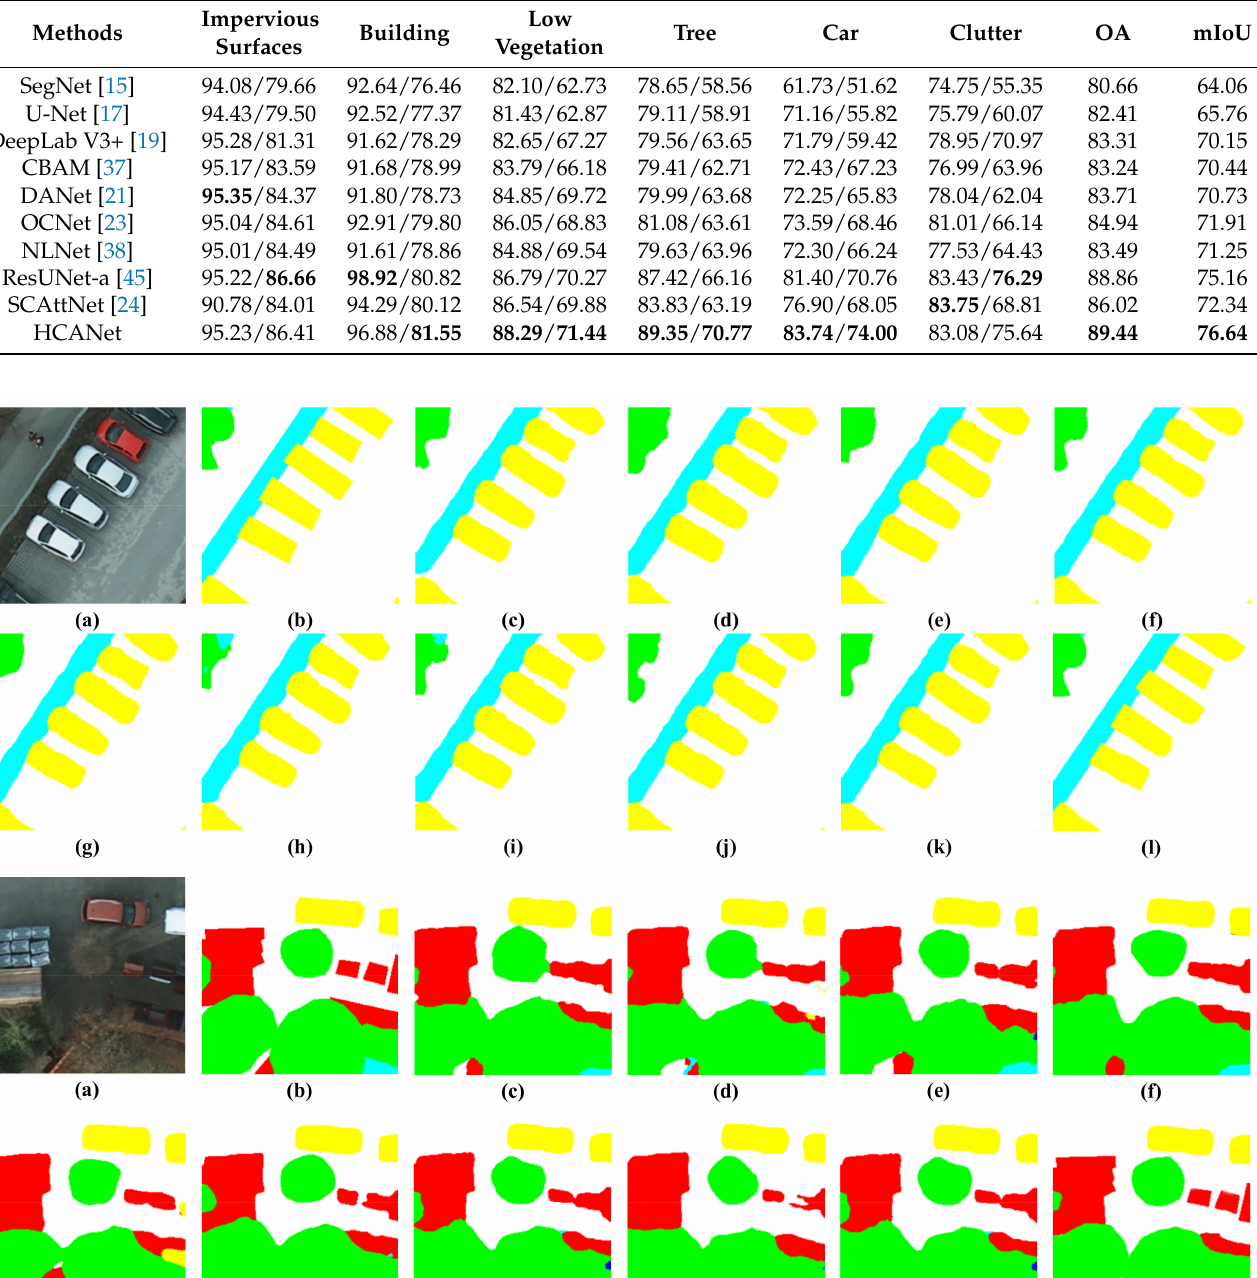
Table 4. Results on Potsdam dataset. Accuracy of each category is presented in the OA/IoU form, and the bold number indicates the best.